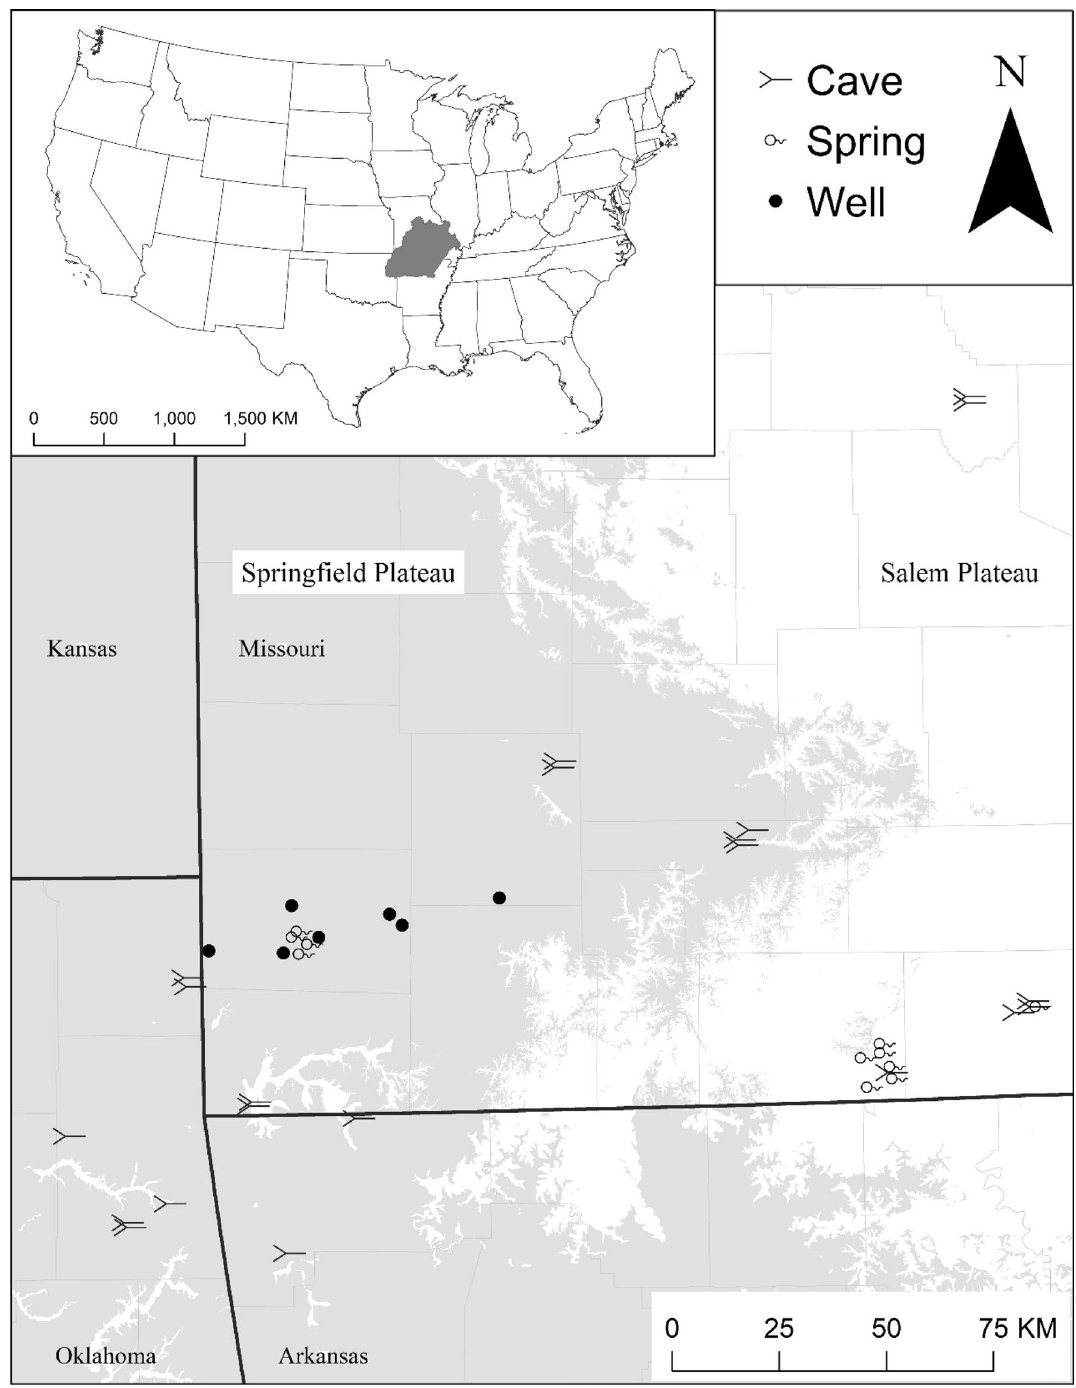
Figure 1. Environmental DNA and visual surveys were conducted for cavefishes and cave crayfishes at 61 sampling units within 21 caves, 12 springs, and seven wells across the Ozarks Highlands ecoregion, USA (dark gray of inset). The lighter gray and white shading on the map represent the Springfield Plateau (i.e., limestone) and Salem Plateau (i.e., dolostone) physiographic regions, respectively. This map was created using ArcGIS software (version 10.4, ESRI, https:// www. esri. com/) by Esri. ArcGIS and ArcMap are the intellectual property of Esri and are used herein under